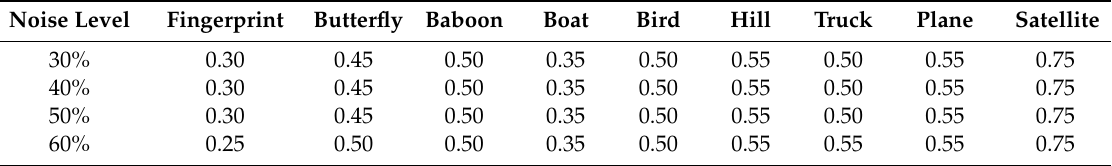
Table 1. Values of p that give optimal peak signal-to-noise ratio (PSNR) values for different test images. Noise Level